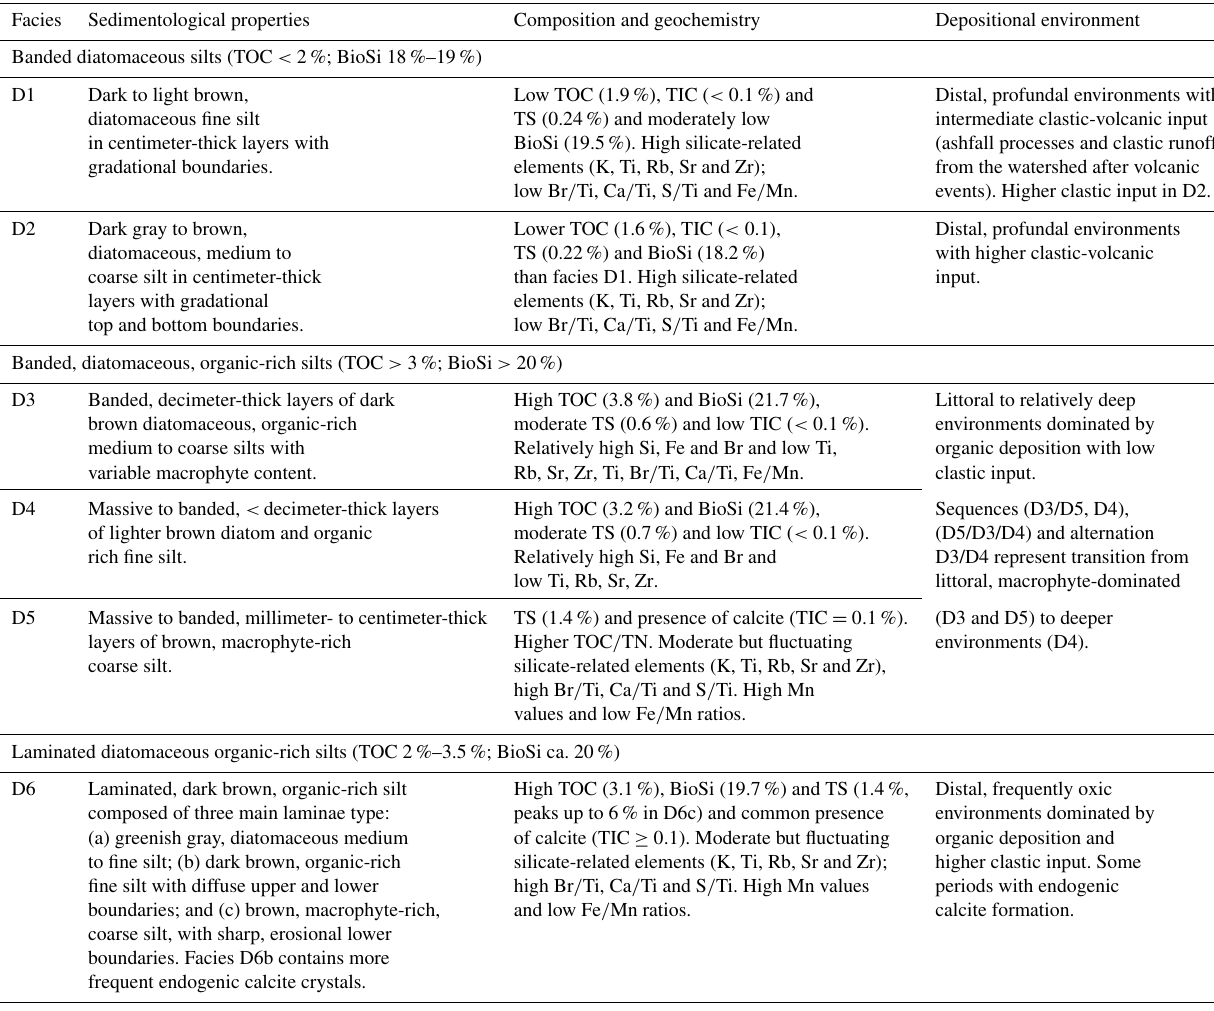
Table 2. Sedimentological and compositional characteristics and depositional environment of LdM lacustrine facies.